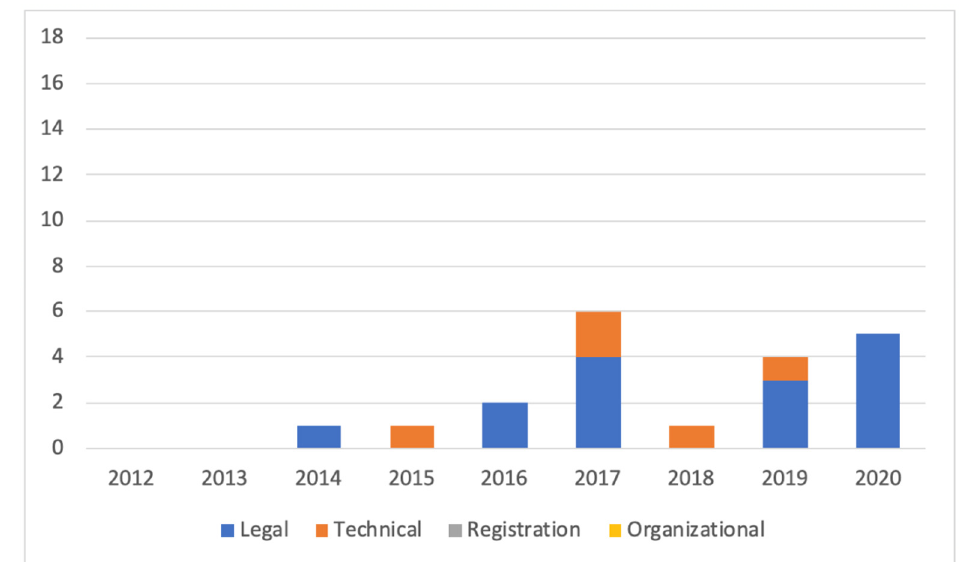
Figure 7. Distribution of LADM related standardization topics.